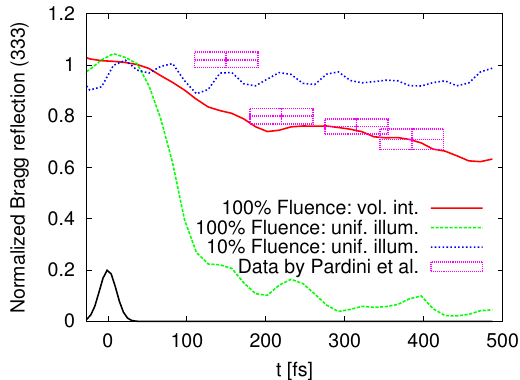
Figure 3. Temporal evolution of the normalized Bragg reflection intensity (333) recorded from Si crystals obtained with our simulations for various fractions of the nominal peak fluence, assuming uniform X-ray illumination: 100% (green curve) and 10% (blue curve), and applying volume inte- gration for the full nominal fluence (red curve). The calculated intensity was normalized using the unperturbed signal value. This was compared to the experimental data from [12]. The FEL pump pulse temporal shape was schematically shown (black solid line). The FEL pulse parameters are as in Figures 1 and 2. Note that the recent analysis performed in [12] excluded the first experimental point at 150 ± 40